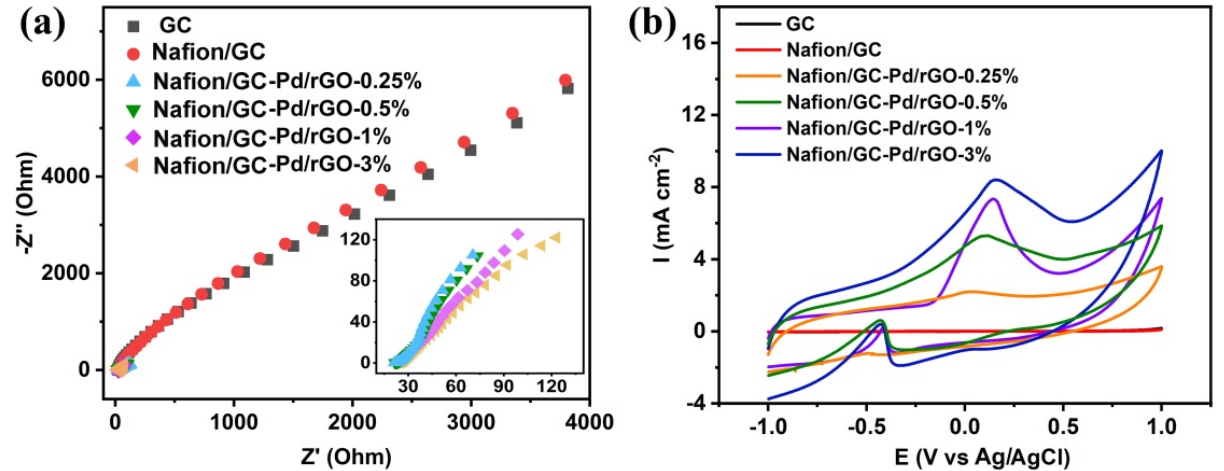
Figure 5. ( a ) Electrochemical impedance spectroscopy (EIS) of the bare GC electrode, the Nafion/GC electrode, the Nafion/GC-Pd/rGO-0.25%, 0.5%, 1% and 3% electrode in 10 mM formaldehyde solution containing 0.5 M NaOH. The frequency range was 10 5 to 10 − 1 Hz at the bias voltage of 0.2 V. The inset is a larger view of Figure 5a in the low frequency region. ( b ) CVs curves of electrode, the bare GC electrode, the Nafion/GC electrode, the Nafion/GC-Pd/rGO-0.25%, 0.5%, 1%, and 3% electrode in 10 mM formaldehyde in 0.5 M NaOH at a scanning rate of 100 mV s − 1 .